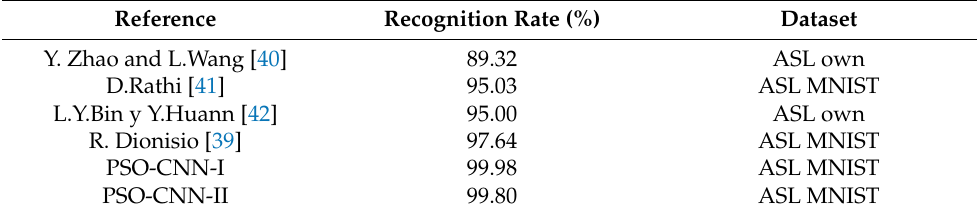
Table 20. State-of-the-Art